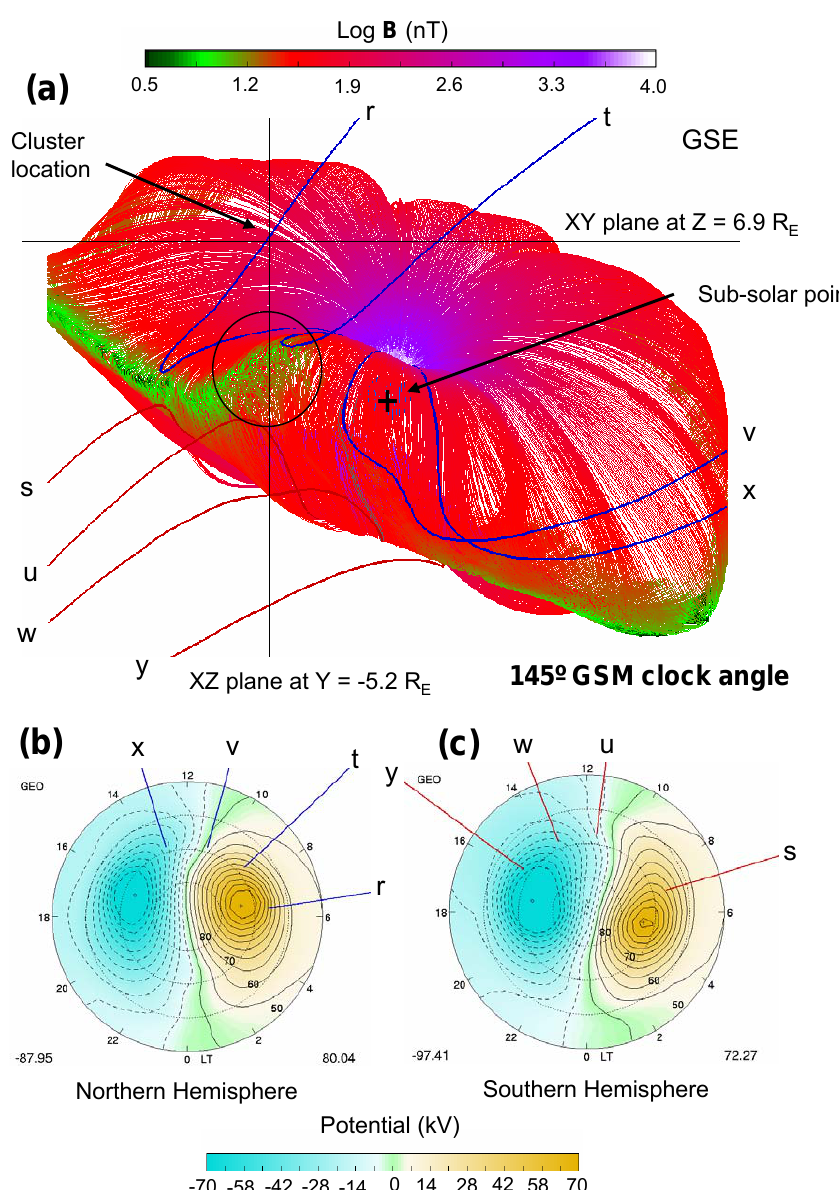
Fig. 4. ISM simulation results with input conditions similar to the average conditions observed during the optical-measurement period. (a) A 3-dimensional view of the magnetopause in GSE coordinates viewed from the Sun. The magnetopause is defined by the sets of last closed field lines mapped from the northern and southern hemisphere ionospheres. Field lines are colored with the log of the magnitude of | B | . Regions of low field strength (green and black) on the magnetopause surface are proxies for probable merging sites. The location of Cluster in this 3-dimensional view is at the intersection of the XY plane (line) at Z =6.9 R E and the XZ plane (line) at Y = − 5.2 R E . Four pairs of first open field lines, labeled r through y, highlight regions of importance in interpreting the 557.7nm emissions (see text). The foot-points of the field lines in the northern and southern hemisphere ionospheres are shown in (b) and (c) with the respective potential patterns as